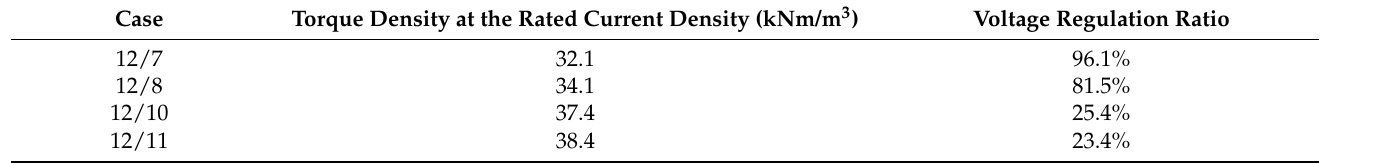
Table 6. Overall comparison of the four